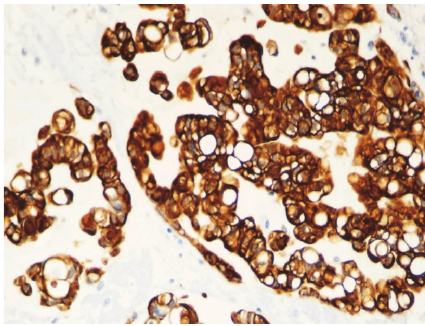
Figure 3: Positivity of the tumor cells for CKAE1/AE3 (20x).